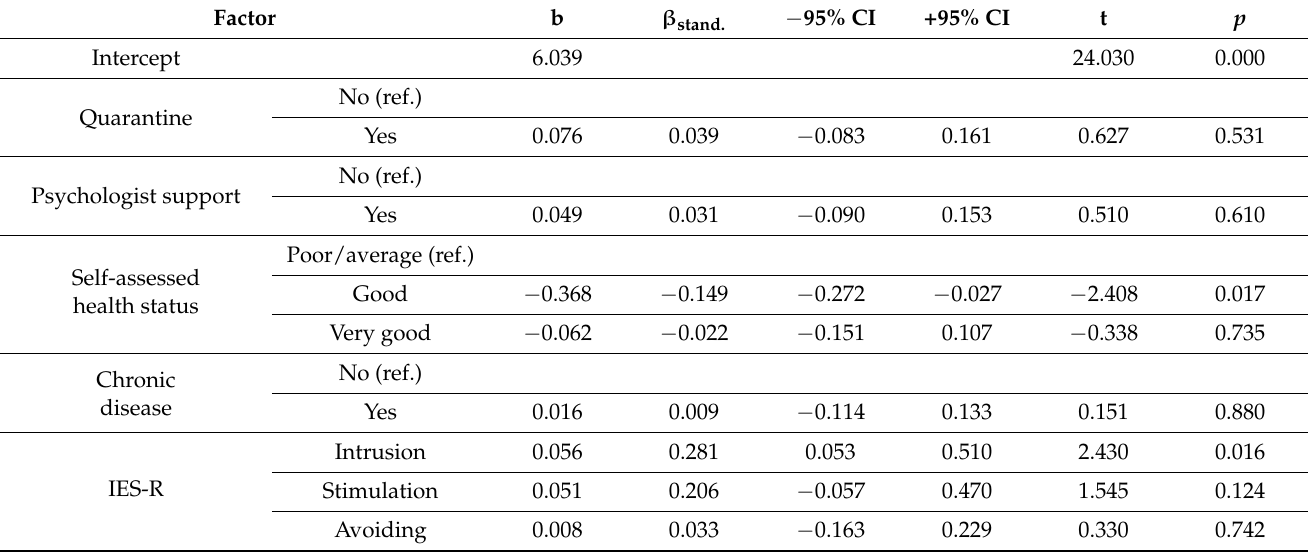
Table 5. Effect of the self-assessment of health, quarantine, psychological support, presence of chronic diseases and dimensions of the Impact of Event Scale—Revised (IES-R) on stress level (model